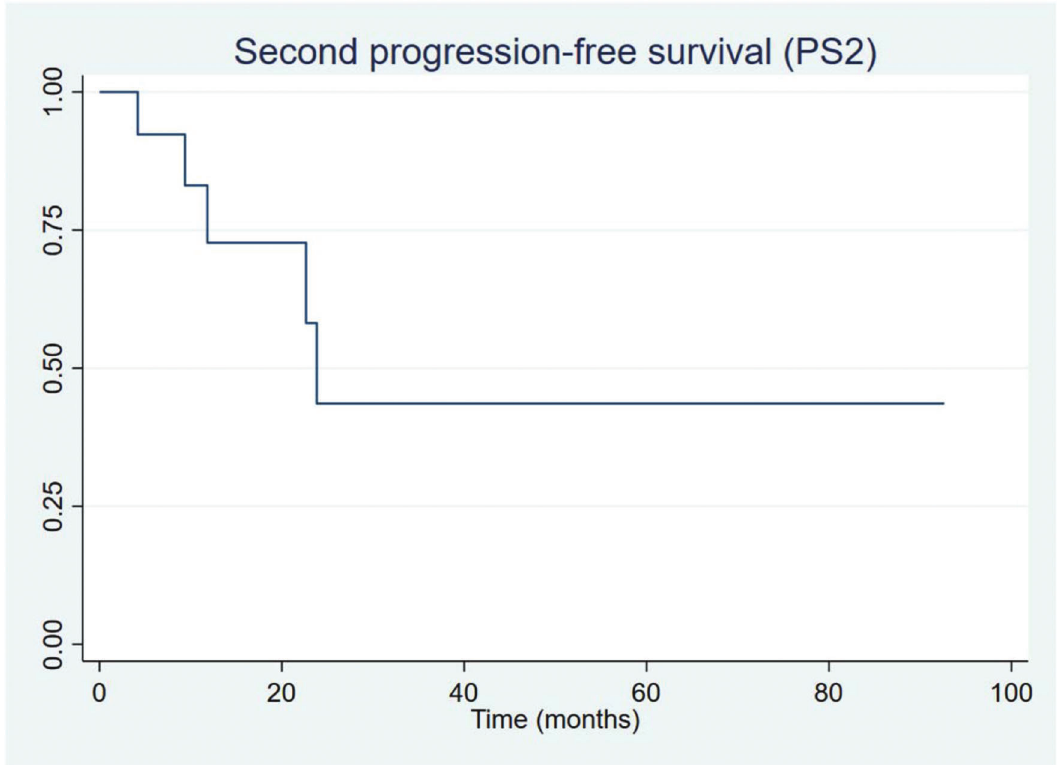
Fig 7 - Second progression-free survival (from the date of first progression).